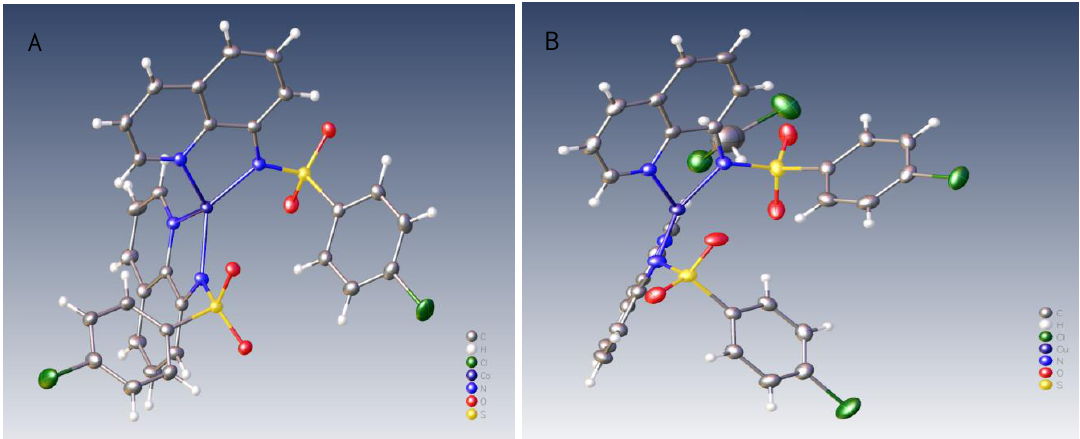
Figure 4. ( A ) Molecular structure of [Co( N -(quinoline-8-yl)-4-chloro-benzenesulfonamide) 2 ] 4c complex. ( B ) Molecular structure of [Cu( N -(quinoline-8-yl)-4-chloro-benzenesulfonamide) 2 ] 4b complex.